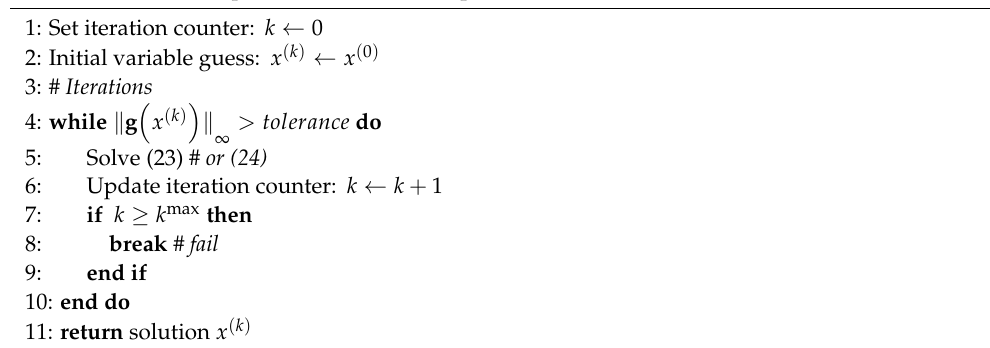
Algorithm 1: Developed PF solution